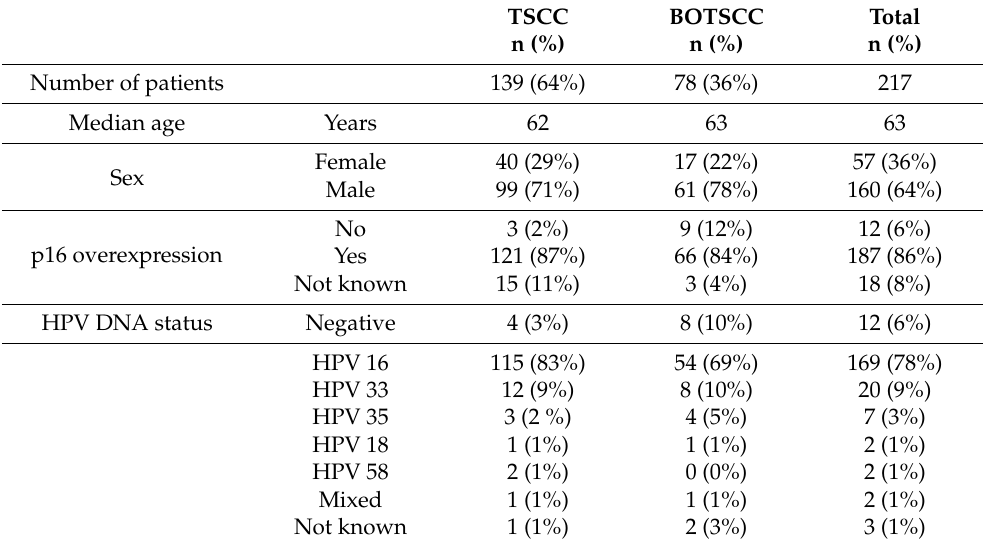
Table 1. Patient and tumour characteristics.